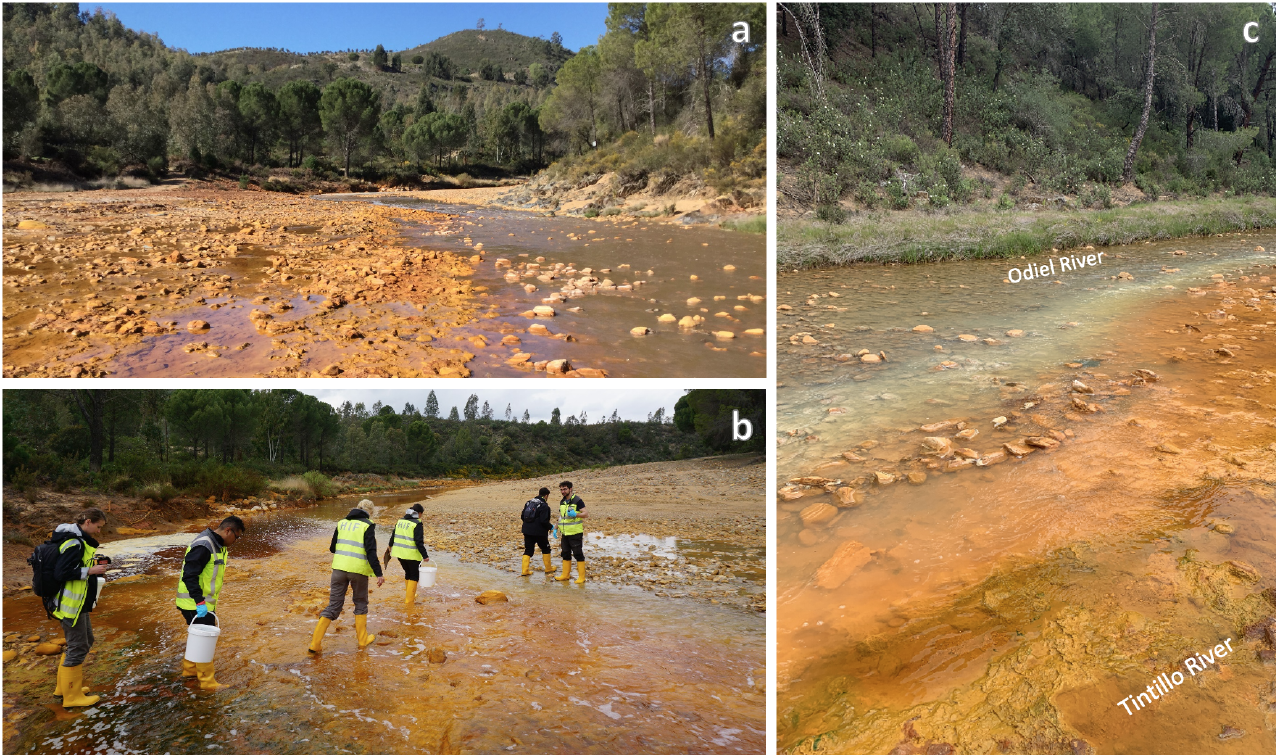
Figure 2. Three pictures of the study area, ( a ) detail of the sediments and the characteristic color of forming layers; ( b ) detail of the distinctive water color during the sampling campaign (17 April 2019); ( c ) detail of the different water color bands, formed by the mixing of waters at the confluence.